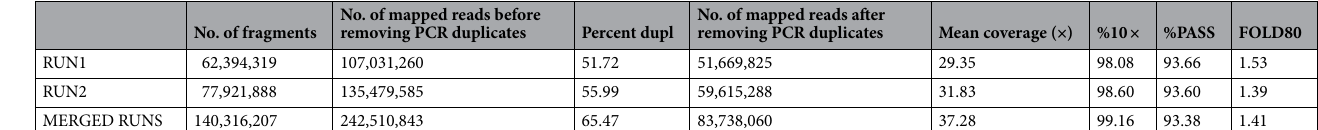
No. of mapped reads before No. of fragments removing PCR duplicates Percent dupl